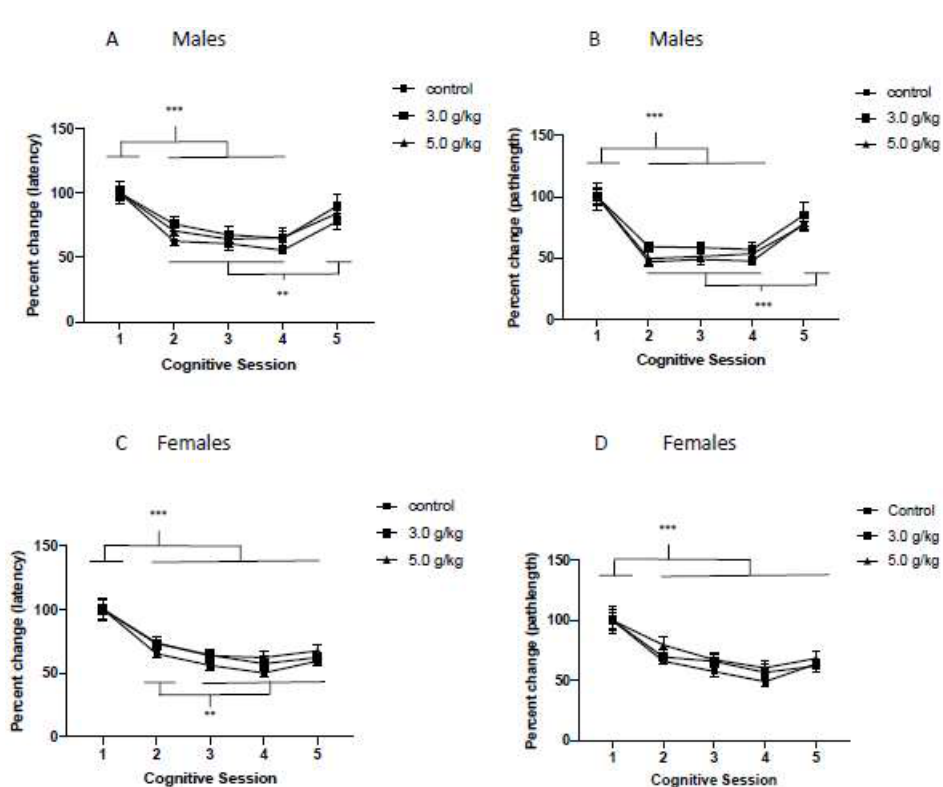
Figure 4. Chronic Intermittent Ethanol Exposure During Adolescence Does Not Impair Spatial Learning. Percent performance in the spatial tests for each cognitive session for males ( A , B ) and females ( C , D ) when measured by either latency to the platform ( A , C ) or swimpath to the platform ( B , D ). Brackets indicate significant post hoc tests while error bars denote standard error of the mean. *** denotes significant difference, p < 0.0001; ** p < 0.05; exact values provided in manuscript. A value above 100% indicates impaired performance relative to performance in CS1 while a value below 100% indicates improved performance relative to performance in CS1.